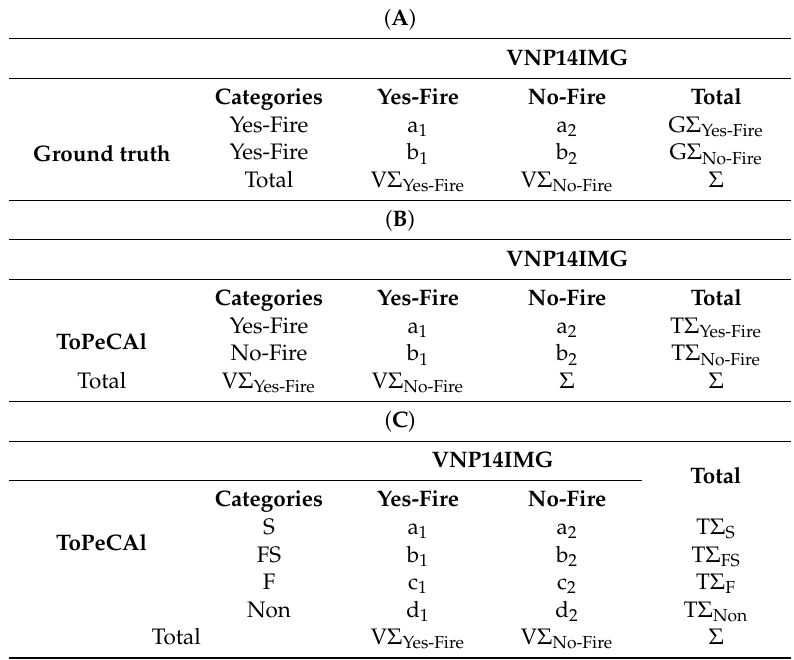
Table 5. ( A ) The design of the Contingency Table for the VNP14IMG product versus ground truth data, ( B ) the VNP14IMG product versus Tropical Peatland Combustion Algorithm (ToPeCAl) results from Landsat-8 based on two categories (Yes-Fire, No-Fire), and ( C ) the VNP14IMG product versus ToPeCAl applied to Landsat-8 based on four categories (F, S, FS, and Non). ( A ) VNP14IMG Categories